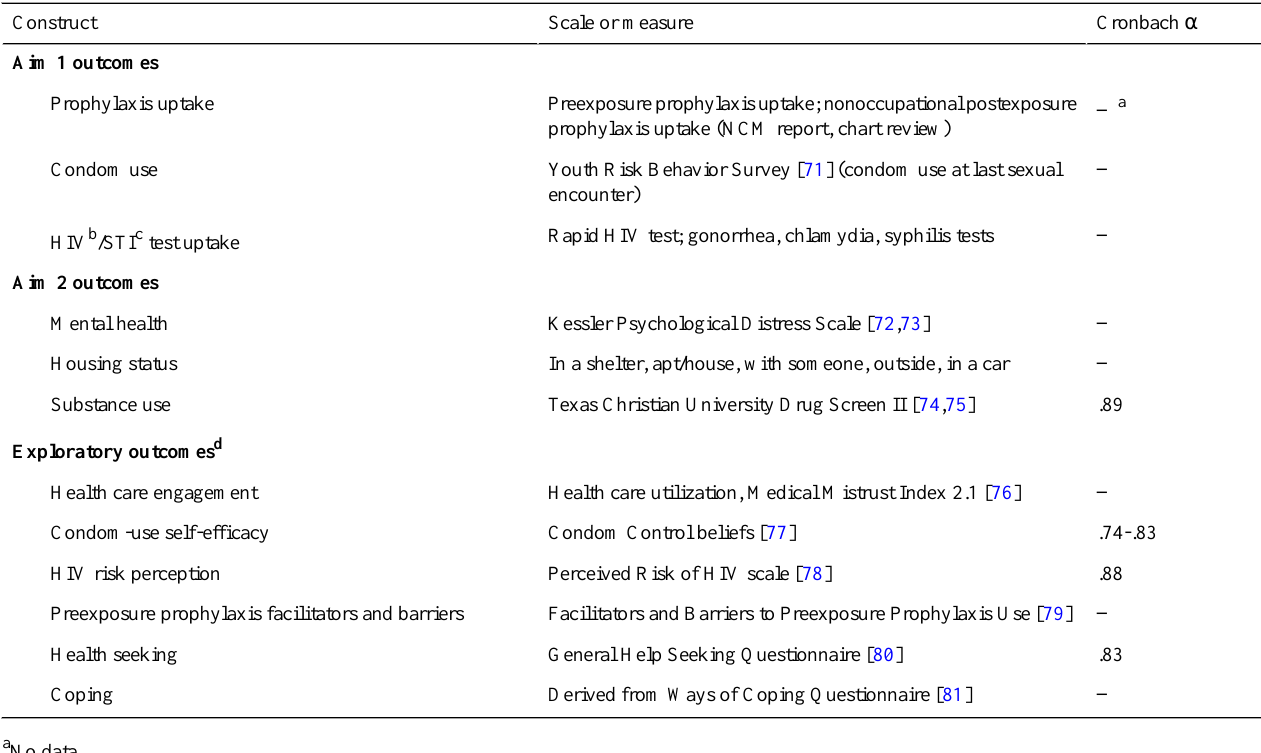
Table 2. Outcome